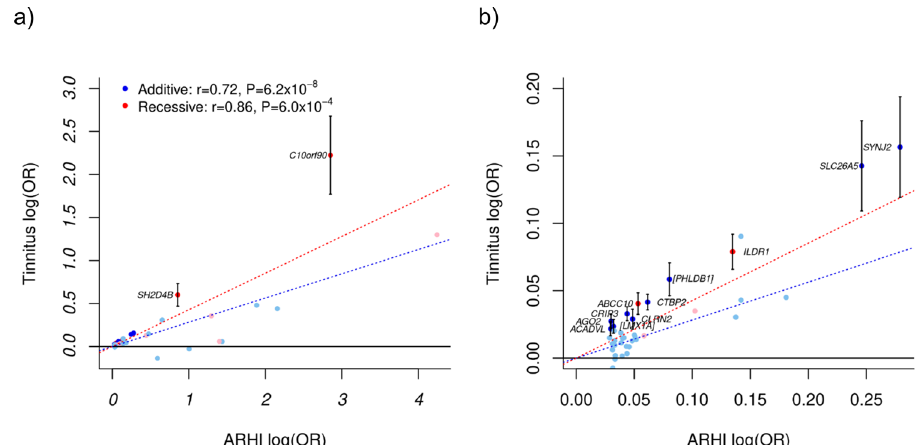
Fig. 6 Effect of the ARHI variants on tinnitus. The effect of the ARHI variants on ARHI is plotted against their effect on tinnitus for a all ARHI variants and b zoomed-in on variants from ( a ) with ARHI OR < 1.35. Effects are shown as the logarithm of the estimated odds ratios. ARHI variants detected under the additive model were tested for tinnitus using the additive model (blue dots) and ARHI variants detected under the recessive model were tested for tinnitus using the recessive model (red dots). The corresponding dashed lines represent results from a linear regression using MAF(1-MAF) as weights. Variants that affect tinnitus, controlling the false discovery rate at 0.05, are plotted with darker color and labeled with their corresponding gene. All effects are shown for the ARHI risk-increasing allele. Error bars represent 95% con fi dence intervals. The dotted lines represent results from a weighted linear regression using MAF(1-MAF) as weights, red for recessive variants and blue for additive, and the weighted correlation coef fi cients ( r ) and the corresponding P -values are shown in ( a